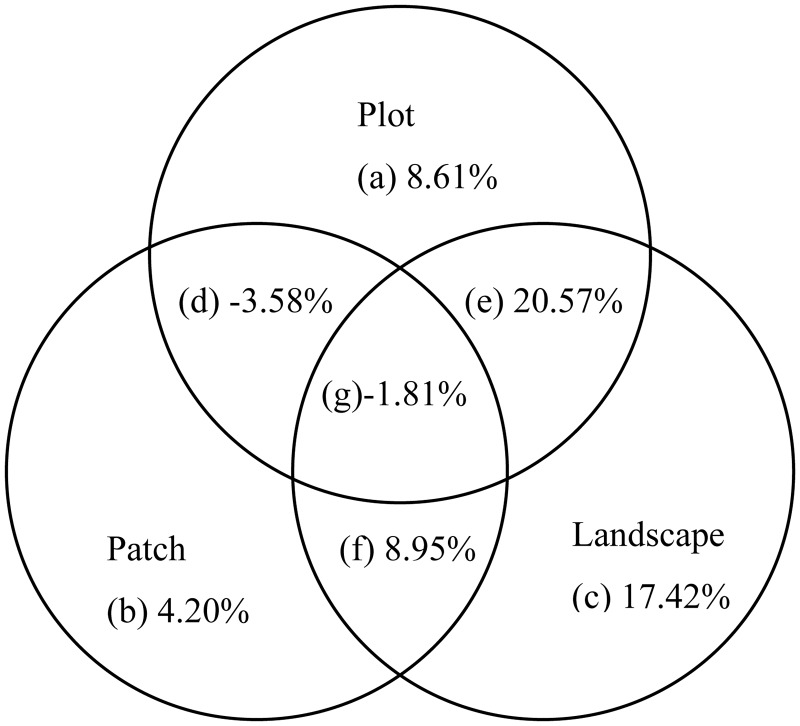
Percentages of the total variance in red-crowned crane occurrence data explained by plot, patch, and landscape variables at the second hierarchical level; a, b, c are unique effects of plot, patch and landscape variables, respectively; d, e, f, g are fractions indicating their combined effects.